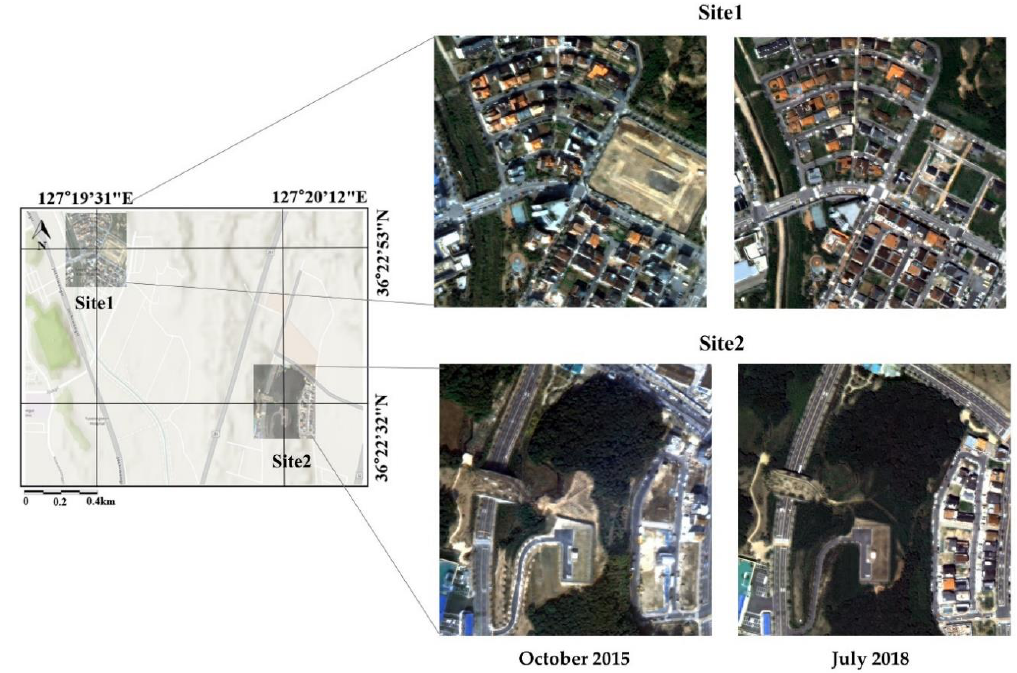
Figure 4. Locations of the two study sites; the background map was obtained from the ArcGIS world map [50]. The upper images are of site1 and the lower images are of site 2. The first images were obtained in October 2015, and the second images were obtained in July 2018. Both the images highlight the differences due to seasonal changes and newly constructed